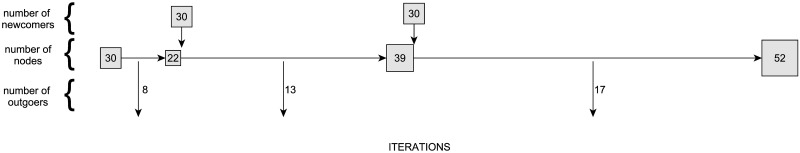
Size of networks at different numbers of iterations, newcomers and outgoers.